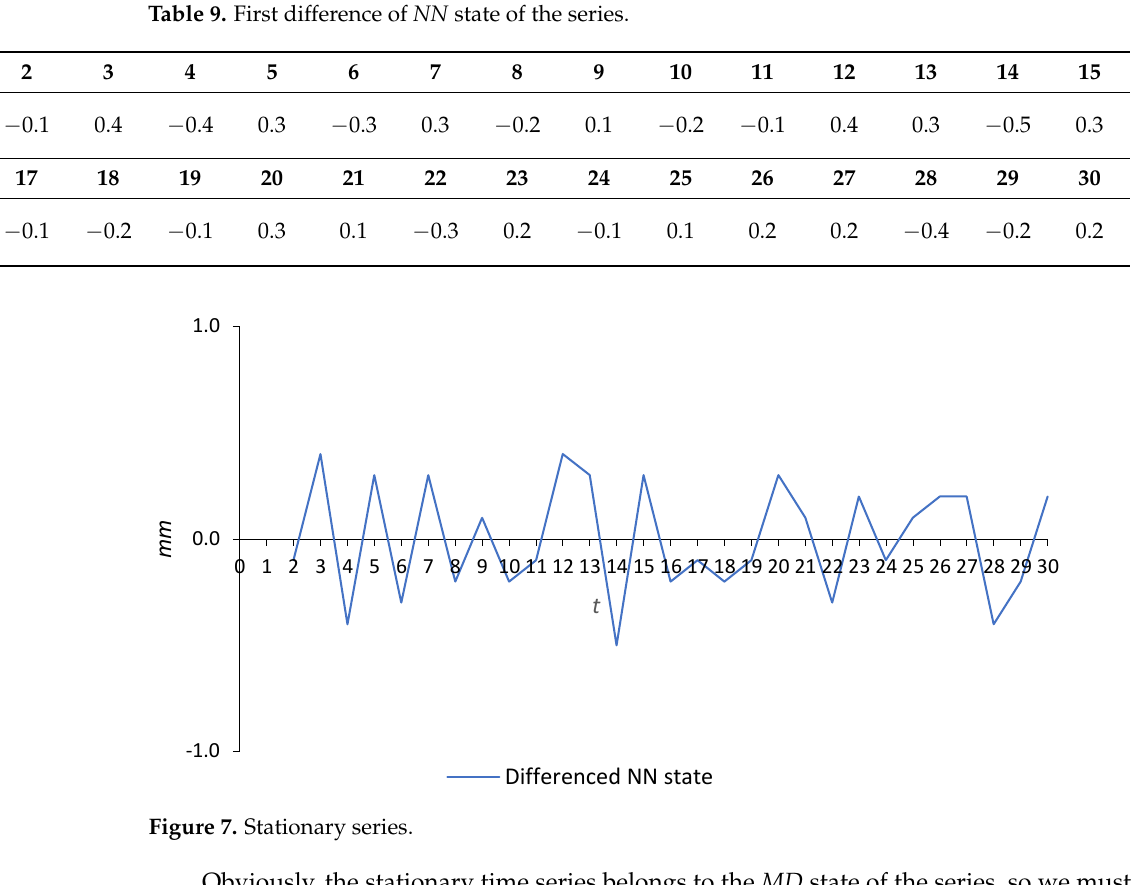
0.2 Figure 8. Transformation of stationary MD state of series.